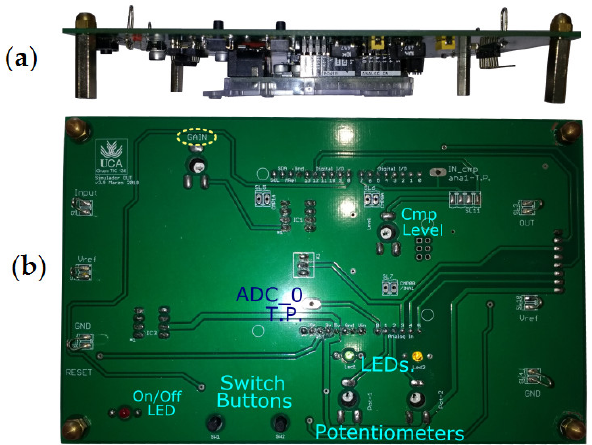
Figure 3. The emulator PCB: ( a ) lateral view, showing the Arduino UNO plugged. ( b ) Top side (work area).